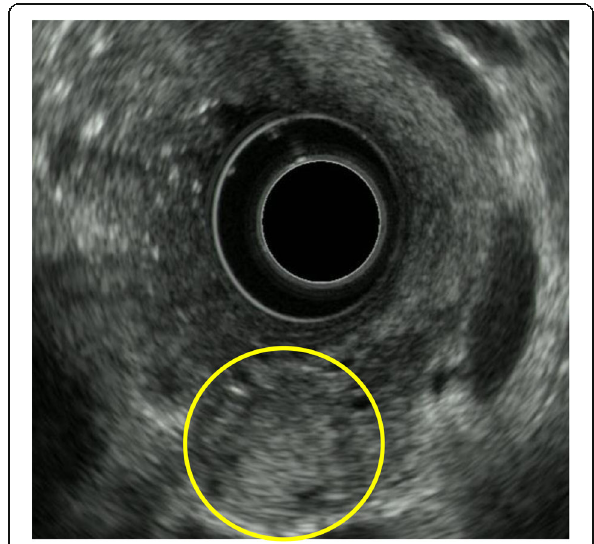
Fig. 4 Endoscopic ultrasound sonography showing the high echoic tumor at the pancreatic head